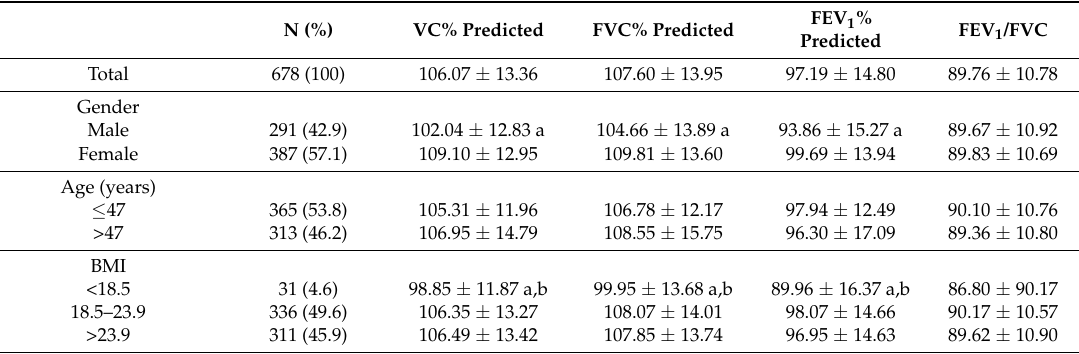
Table 1. The mean values and standard deviations (SDs) of lung ventilation function indicators among greenhouse